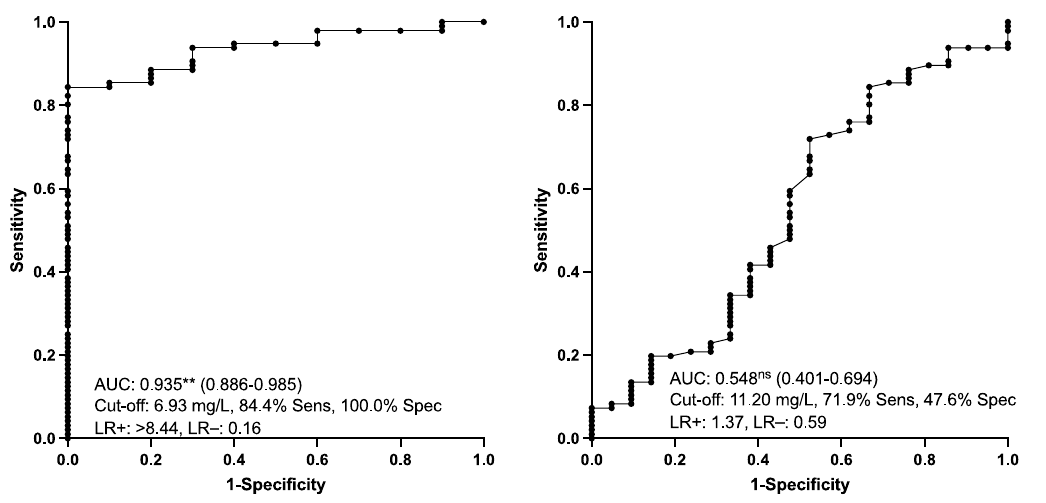
Figure 3. Salivary calprotectin concentrations. Receiver operating characteristic (ROC) analysis for discriminating between animals with EGUS from healthy ones ( left ) and EGUS from other diseases ( right ). AUC, the area under the curve (95% confidence interval within parenthesis); Sens, sensitivity; Spec, specificity; LR, likelihood ratio. Statistical analysis: **: p < 0.01; ns: p > 0.05).